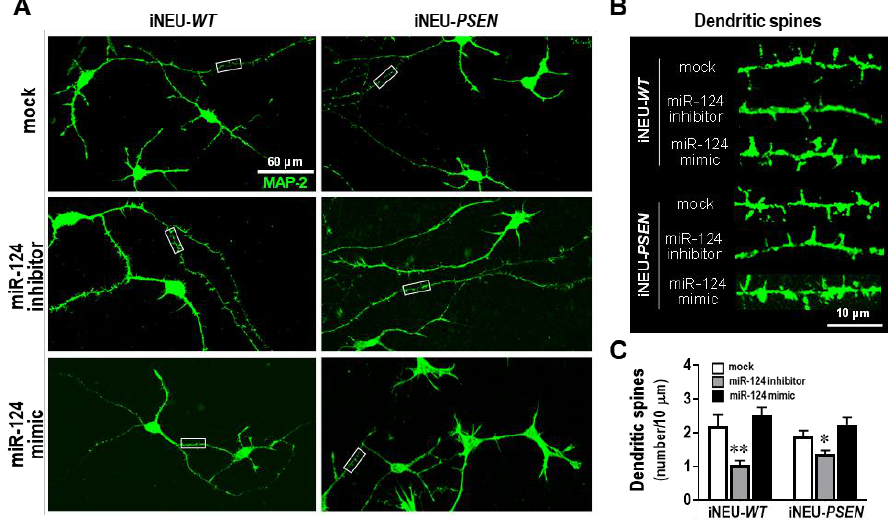
Figure 4. Dendritic spine number decrease in iNEU- WT and iNEU- PSEN cells by modulation with the miR-124 inhibitor, but no changes were noticed for the mimic relatively to the mock transfection. Cells were obtained, differentiated, and transfected, as detailed in Material and Methods. ( A ) Rep- resentative fluorescence images of MAP-2 (green) staining in axons and dendrites in the different conditions. ( B ) Representative images of high magnification of dendritic segments (from panel A insets) with the miR-124 modulation. ( C ) Quantification of the dendritic spine number in each of the conditions. Results are mean ± SEM from at least three independent experiments. * p < 0.05 and ** p < 0.01 vs. respective mock controls, one-way ANOVA with Bonferroni post-hoc test. miR, miRNA; iNEU- WT , iNeurons derived from induced pluripotent stem cells (iPSCs) generated from a healthy control; iNEU- PSEN , iNeurons from iPSCs generated from a patient carrying the PSEN1 ΔE9 mutation.